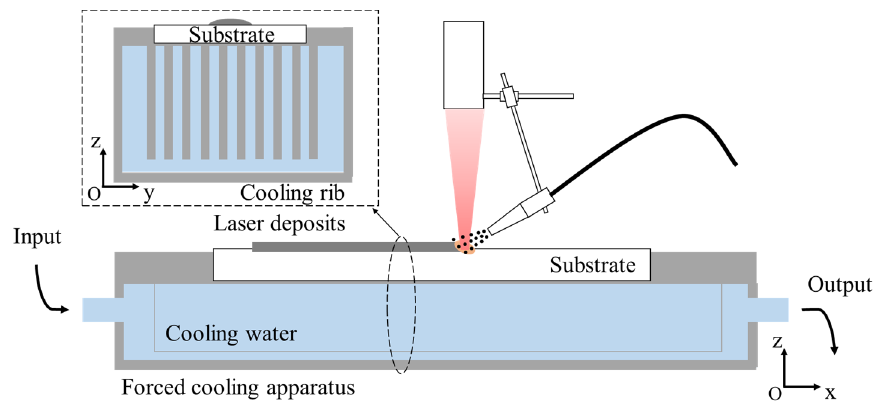
Figure 3. The forced cooling condition used in laser deposition.